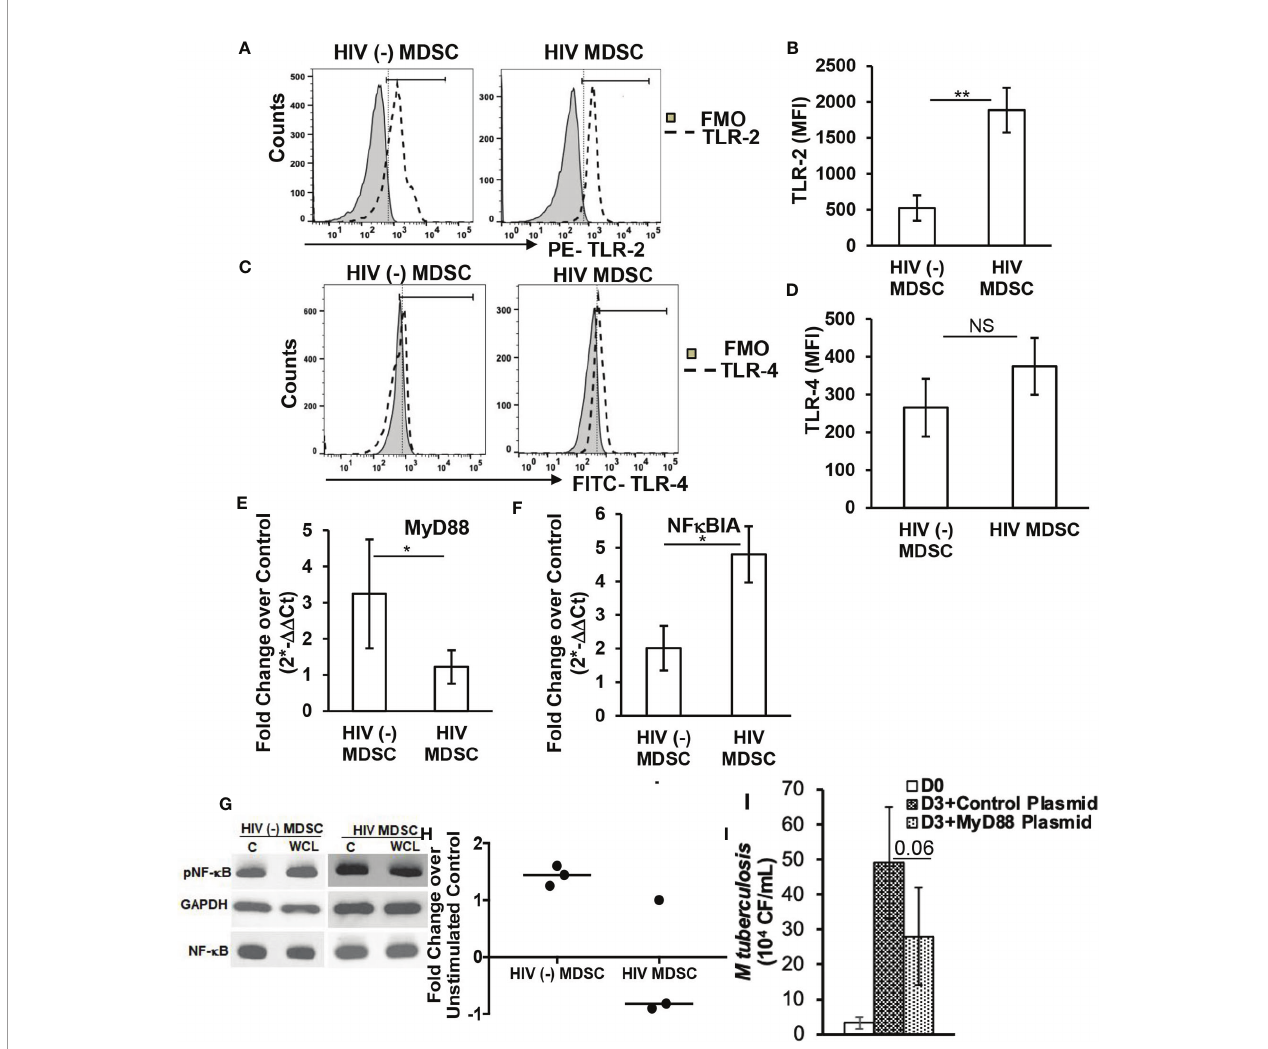
FIGURE 2 | HIV MDSC exhibit truncated TLR signaling. HIV (-) MDSC and HIV MDSC were isolated as in Figure 1 . MDSC were surface stained with (A, B) anti- TLR2 and (C, D) anti-TLR4 antibodies. The expression of TLR-2 and -4 was determined by fl ow cytometry and Mean Fluorescence Intensity (MFI) calculated. Representative fl ow cytometry plots of TLR-2 and -4 are shown; vertical line is median. (E, F) MDSC were cultured without or with M tuberculosis WCL for 24-48 hours, expression of housekeeping gene 18S RNA and MyD88 (E) and NF k BIA (F) and was determined using TaqMan Gene expression assay, and DD C T = D C T, − ( △△ C T ) . (G, H) Total cellular lysates of MDSC cultured without or with M tuberculosis WCL were prepared and WCL - D C T,control. The fold change was calculated as 2 immunoblotted using anti-GAPDH, -total NF k B p65 and – p (S536) NF k B p65 antibody. Fold change was calculated as pNF k B p65 expression in M tuberculosis WCL stimulated cells/pNF k B p65 expression in unstimulated cells. Representative Immunoblot of one HIV (-) and HIV (+) donor is shown (G) . (I) 0.5 x 10 6 MDSC were transfected with empty vector (Control plasmid) or MyD88 containing expression plasmid (MDSC) using Lipofectamine 3000 reagent. After 16-18 hrs post- transfection, DR hi monocytes and MDSC were infected with M tuberculosis at MOI of 1:5 and M tuberculosis growth (colony forming units (CFU)/ml) was determined in the cellular lysates at day-0 and -3 post-infection (p.i.). For (B, D) histograms are shown for N=9 HIV (-) and N= 17 HIV (+) donors; for (E, F) histograms are shown for N= 6 HIV (-) and N= 8 HIV (+) donors; for (H) dot represents an individual donor; horizontal line represents the median; for (I) histograms shown are for N=3 donors. All histograms show mean values +/- SEM. *p < 0.05, **p < 0.005. NS, Non Signi fi